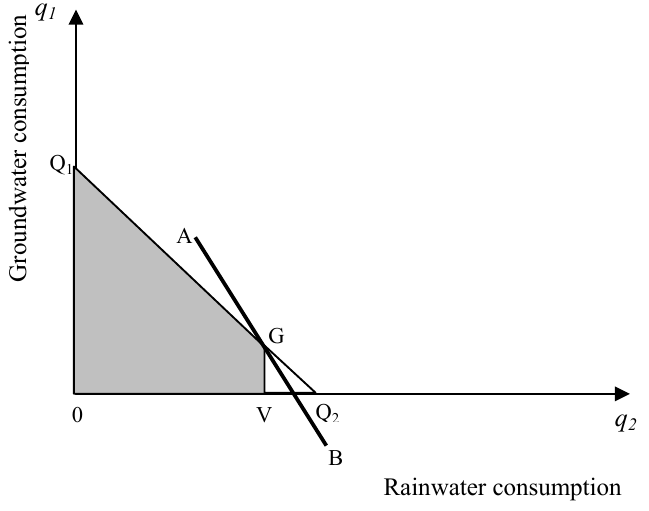
Figure 10. Optimal solution 3 (the isoprofit slope